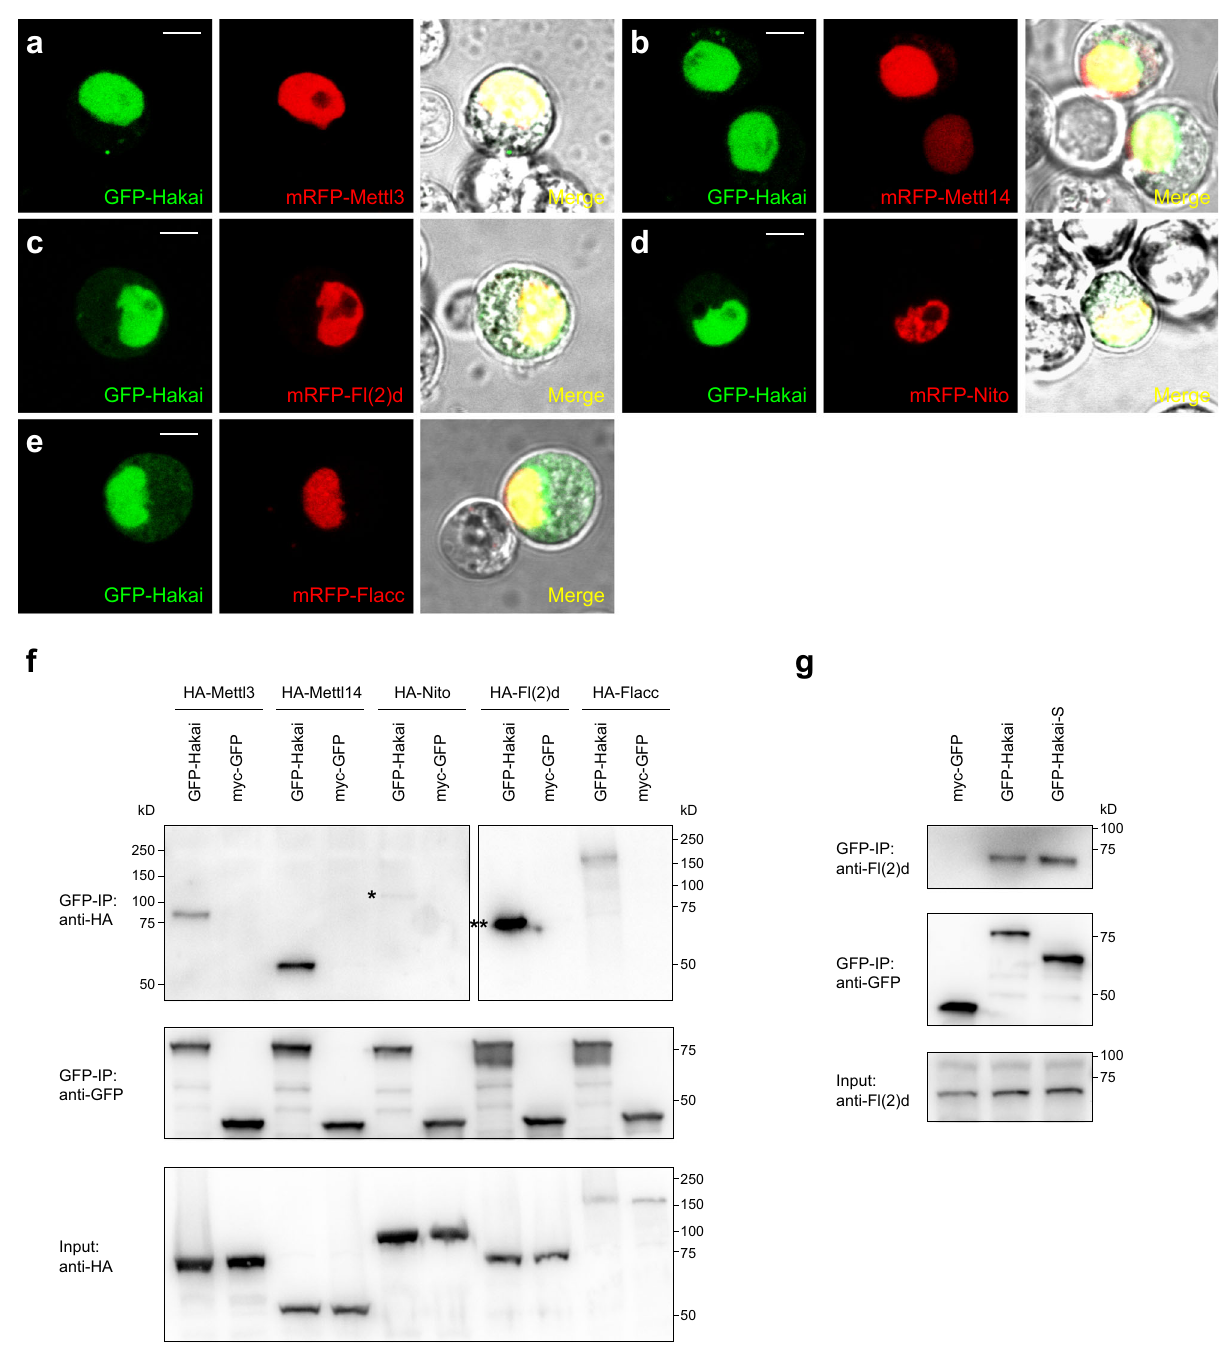
Fig. 1 Hakai colocalizes and interacts with other m 6 A writer components. a – e GFP-Hakai and mRFP-Mettl3, mRFP-Mettl14, mRFP-Fl(2)d, mRFP-Nito, or mRFP-Flacc were co-transfected into S2 cells and their subcellular localization examined in live conditions. All the proteins were predominantly nuclear and GFP-Hakai showed strong co-localization with other factors. Scale bars: 5 μ m. f GFP-Hakai or myc-GFP and HA-Mettl3, HA-Mettl14, HA-Nito, HA-Fl(2)d, HA-Flacc were co-transfected into S2 cells. Cell lysates were immunoprecipitated using GFP nanobody and analyzed by western blot. myc-GFP was used as a control. GFP-Hakai can pull down HA-Mettl3, HA-Mettl14, HA-Nito, HA-Fl(2)d, and HA-Flacc. Note that much more HA-Fl(2)d was co-IPed than other factors (double asterisk), while the interaction with Nito was the weakest (asterisk). g myc-GFP, GFP-Hakai, or GFP-Hakai-S (short isoform) were transfected into S2 cells. Cell lysates were immunoprecipitated using GFP nanobody and analyzed by western blot. GFP-Hakai and GFP-Hakai-S can pull down endogenous Fl(2)d protein to a similar level. Source data are provided as a Source Data fi le. The experiments in a – g were repeated at least twice independently with similar